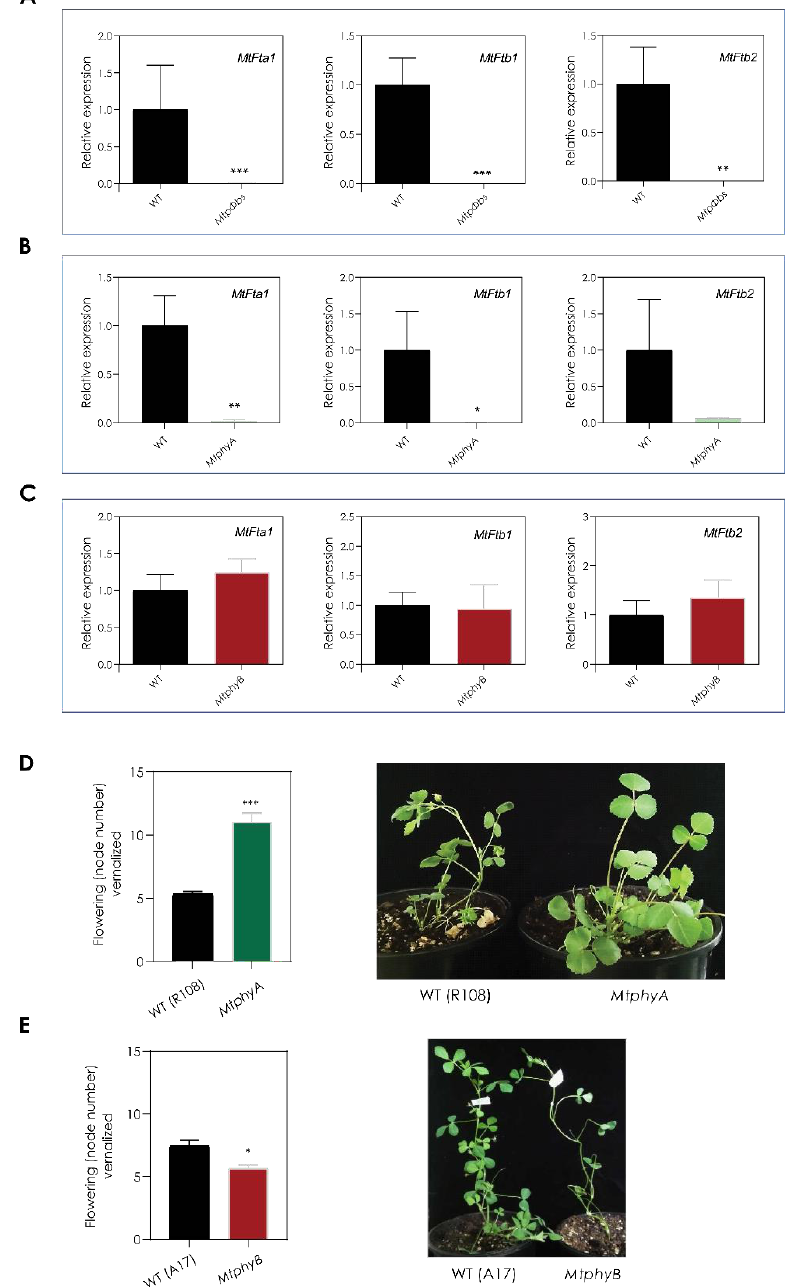
Figure 3. The Mtp Φ bs mutant shows downregulation of MtFT -like genes. Gene expression of Mt, FTa1, FTb1 and MtFTb2 in ( A ) Mtp ϕ bs , ( B ) MtphyA and ( C ) MtphyB mutants, and respective WT